Question: Express in one sentence what the figure is showing.
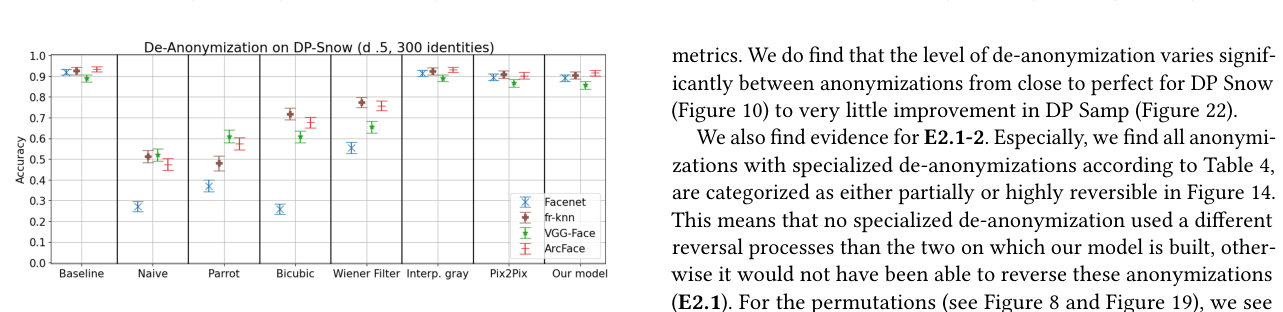
Answer: Recognition accuracy for DP Snow, given for base- line, naive, parrot, de-anon. via bicubic interpolation, via Wiener Filter, via interpolate gray, via Pix2Pix, and via our model; on 300 identities of CelebA.